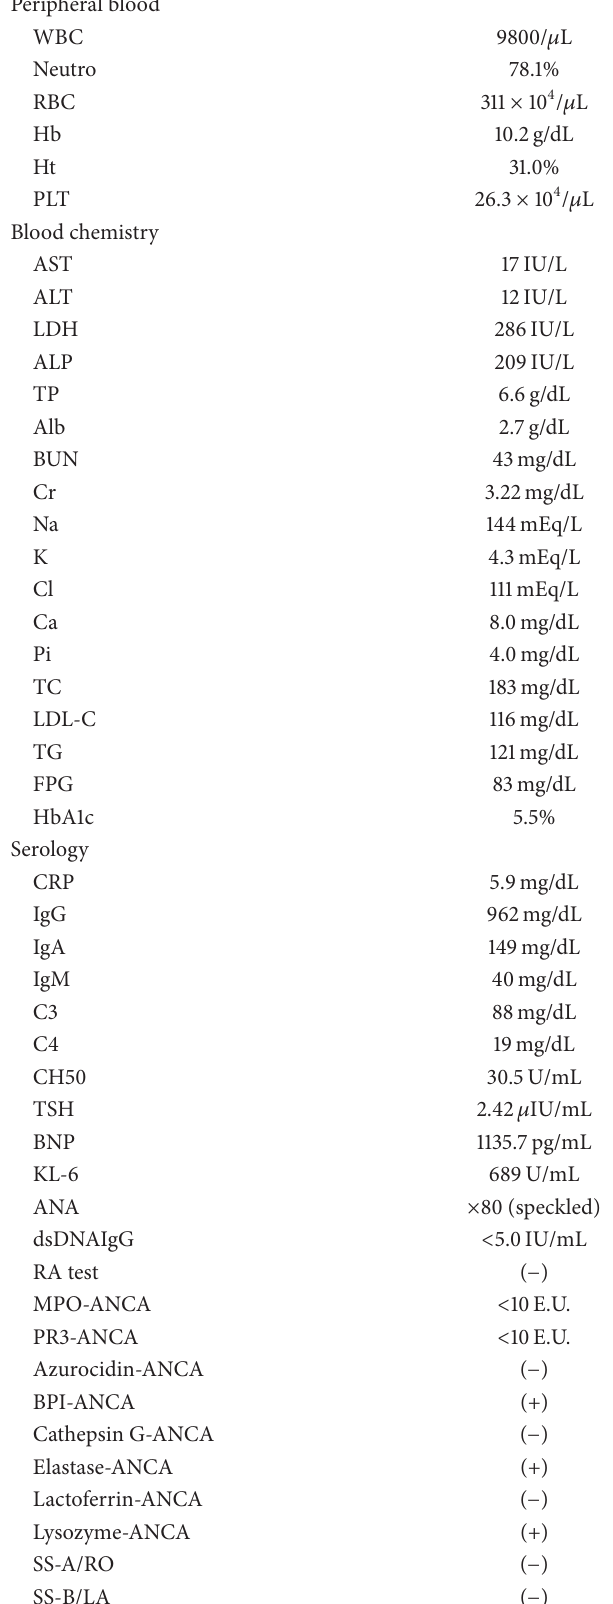
Table 1: Laboratory findings on